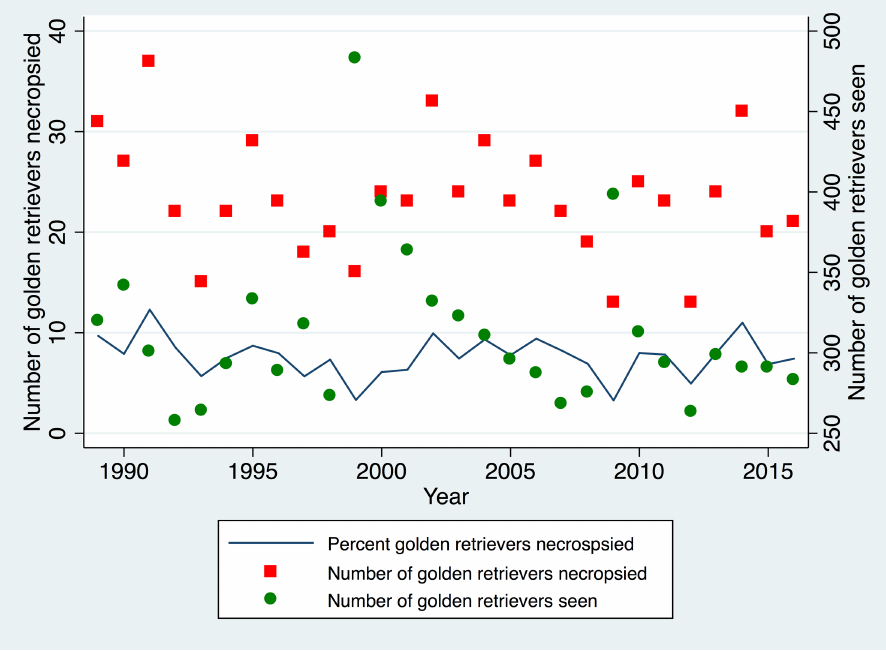
Fig 2. Golden retriever dogs seen and undergoing necropsy. Scatter plot showing in green circles the total number of golden retrievers per year undergoing necropsy exam and in red squares the total number of golden retrievers seen in the hospital per year. The solid line represents the percentage of golden retrievers undergoing necropsy divided by the total golden retriever animals seen that